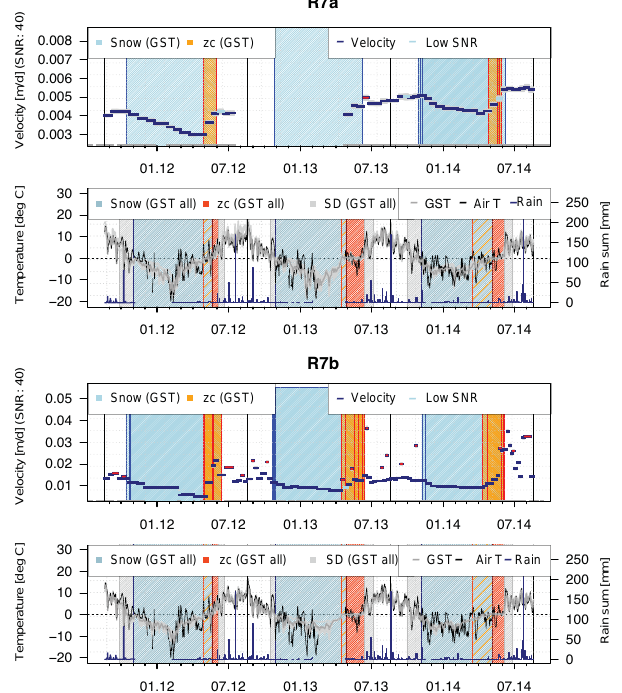
Figure 6. As Fig. 4 but for rock glacier Dirru (R7a and